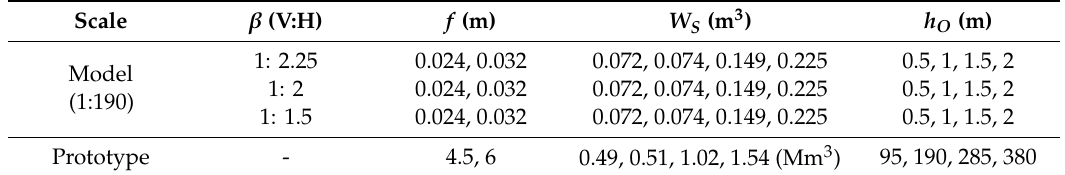
Table 1. Test program.